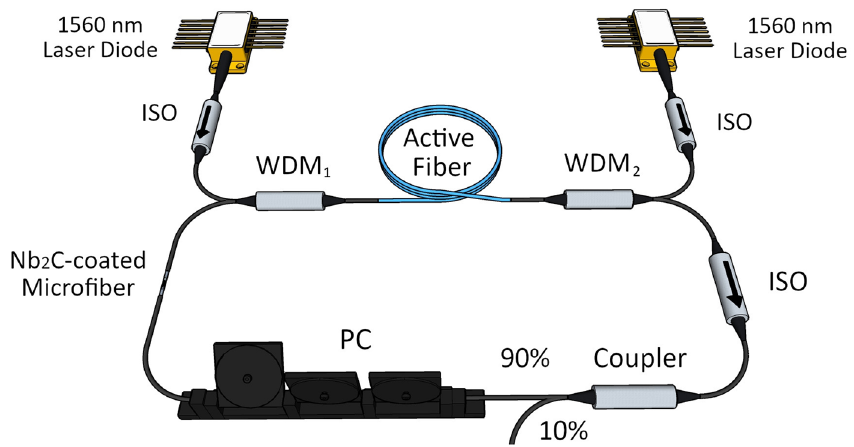
Figure 5. Schematic diagram of 2.0 µm passively mode-locked fiber laser cavity. This figure was drawn using SketchUp Make 2017 (Basic), Software Version: Windows 64-bit 17.2.2555, available at https:// www. sketc hup. com/ downl oad/ all.